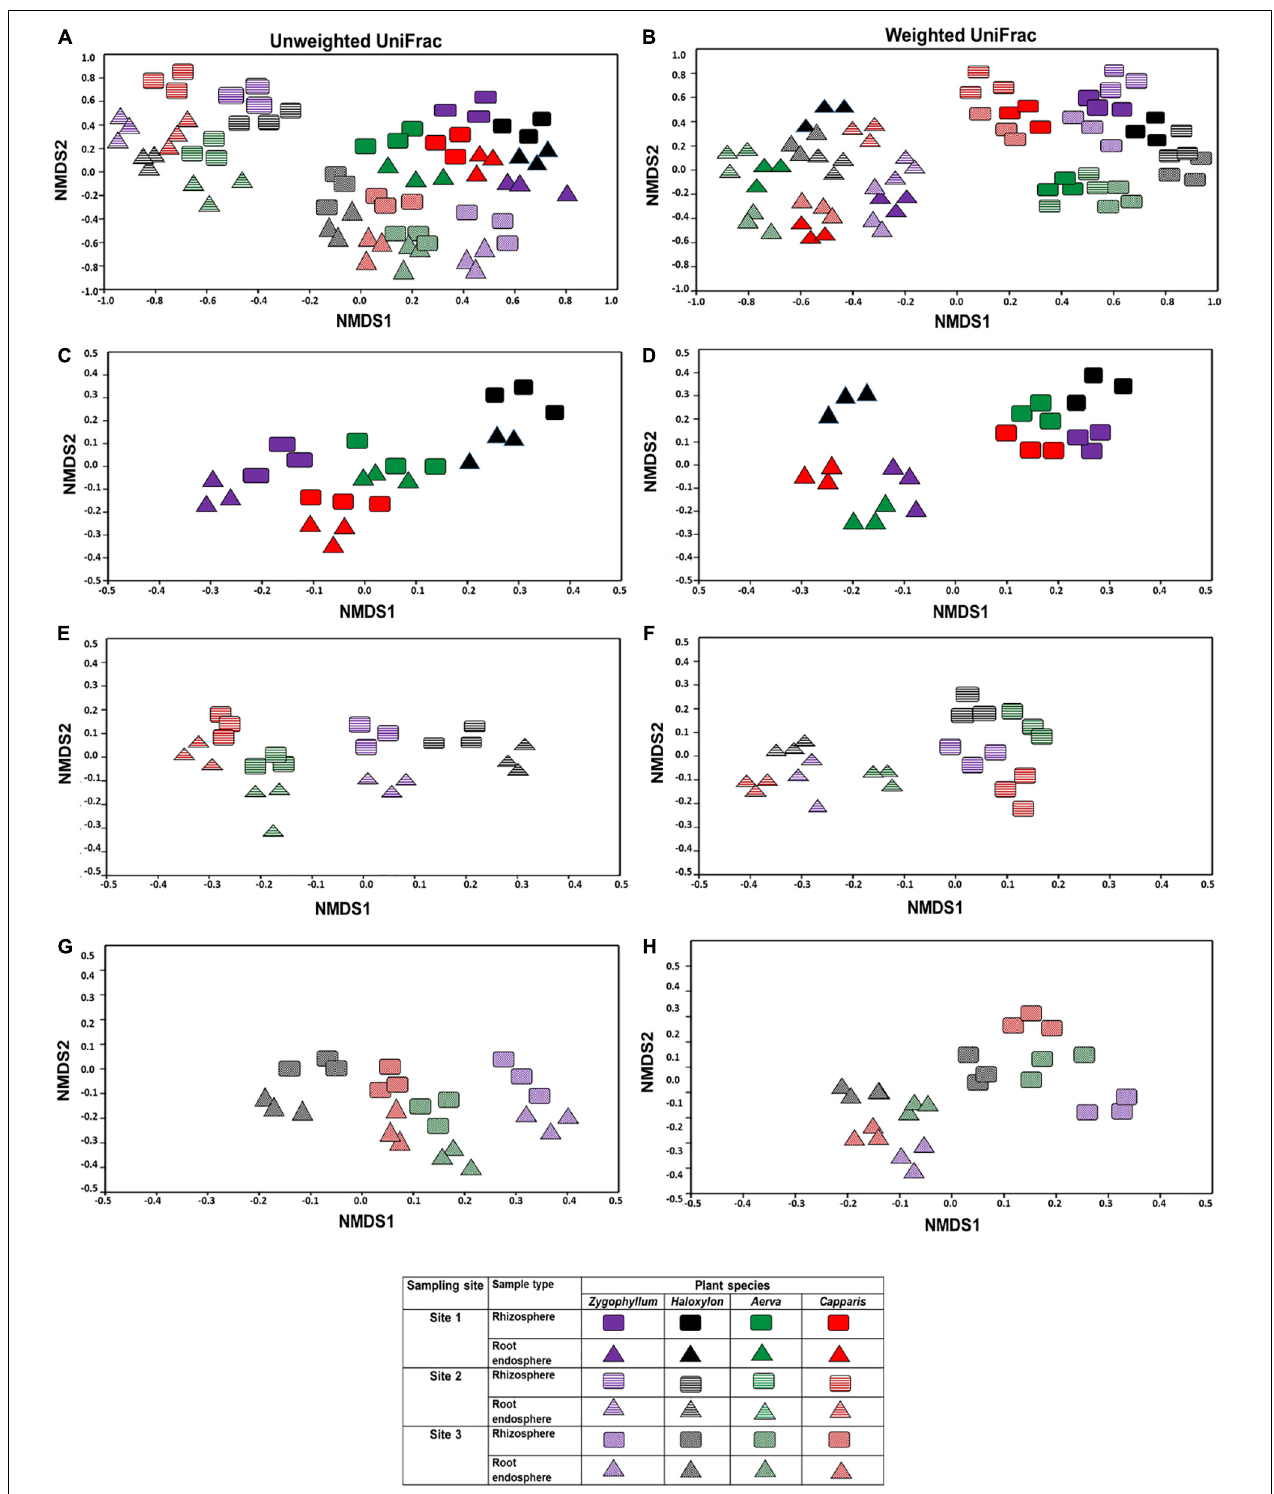
FIGURE 3 | Beta diversity index of the bacterial communities in the rhizosphere and root endosphere of desert halophytes. Beta diversity was calculated by using weighted and unweighted UniFrac distances for non-metric multidimensional scaling plots (A,B) samples collected from all the sites, (C,D) samples collected from only site 1, (E,F) samples collected from only site 2, and (G,H) samples collected from only site 3 using unweighted (A,C,E,G) and weighted (B,D,F,H) UniFrac distances.